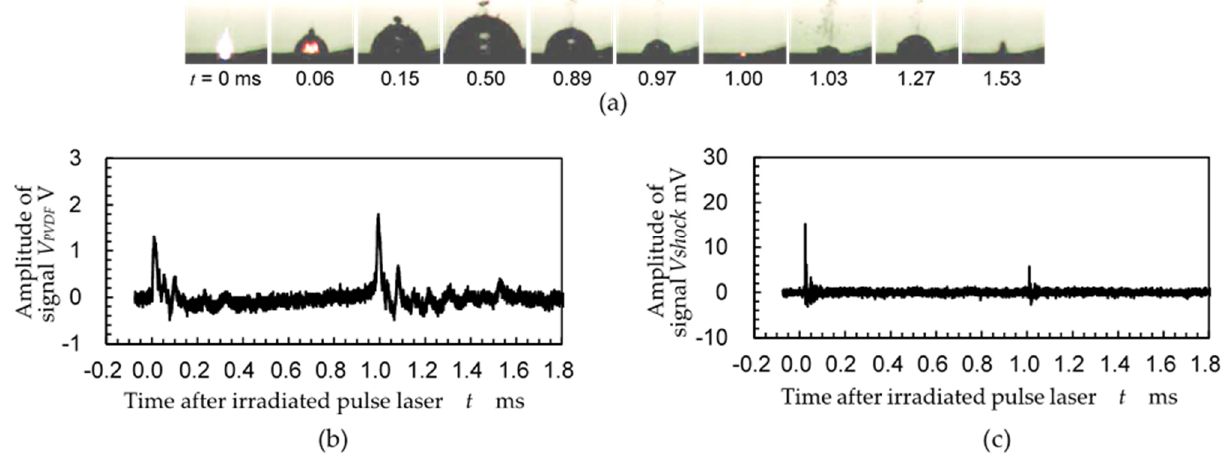
Figure 3. LA and LC produced by a pulse laser at λ = 1064 nm. ( a ) LA and LC; ( b ) signal from a PVDF sensor; ( c ) signal from submerged shockwave sensor.